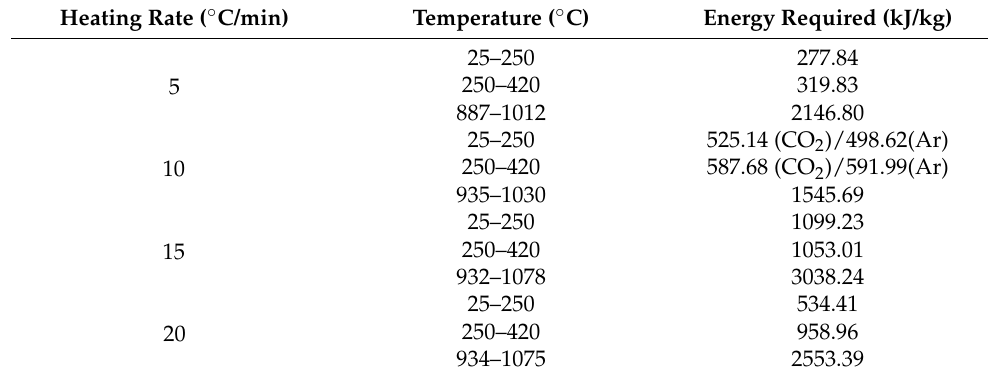
Figure 6. Energy required for the pinewood sawdust: ( a ) different heating rates and ( b ) CO 2 and Ar atmosphere. Table 4. The energy required for each stage at different heating rates.